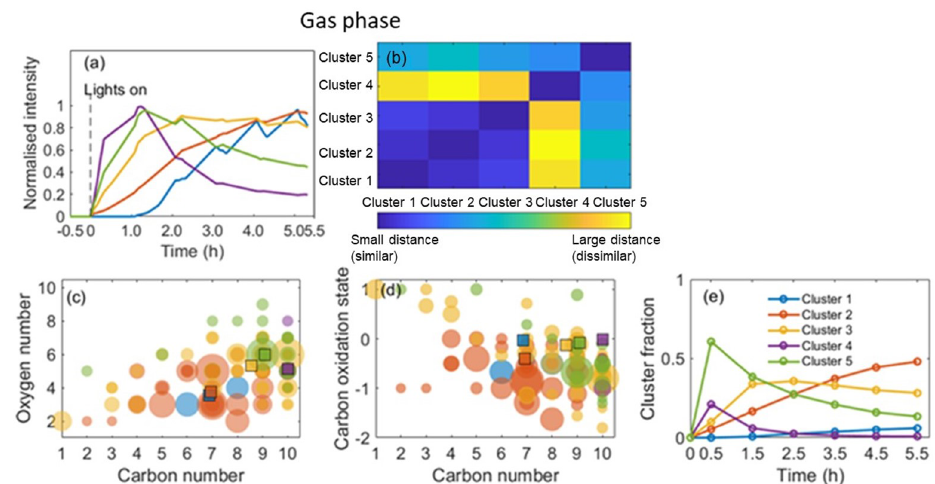
Figure 5. Hierarchical clustering of gas-phase oxidation products from the representative α -pinene system. (a) Time series of each cluster normalized to the highest ion intensity between 0 and 1. (b) Matrix showing the relative distance between clusters. (c) Carbon number vs. oxygen number for each cluster. (d) Carbon number vs. oxidation state for each cluster. (e) Time series of the sum of ions’ normalized signal fractions to the total signal in each cluster. Note that the square symbols represent the contribution of weighted-average carbon numbers, oxygen numbers, and/or OS C in each cluster. The colours correspond to the ones in panel (a) .